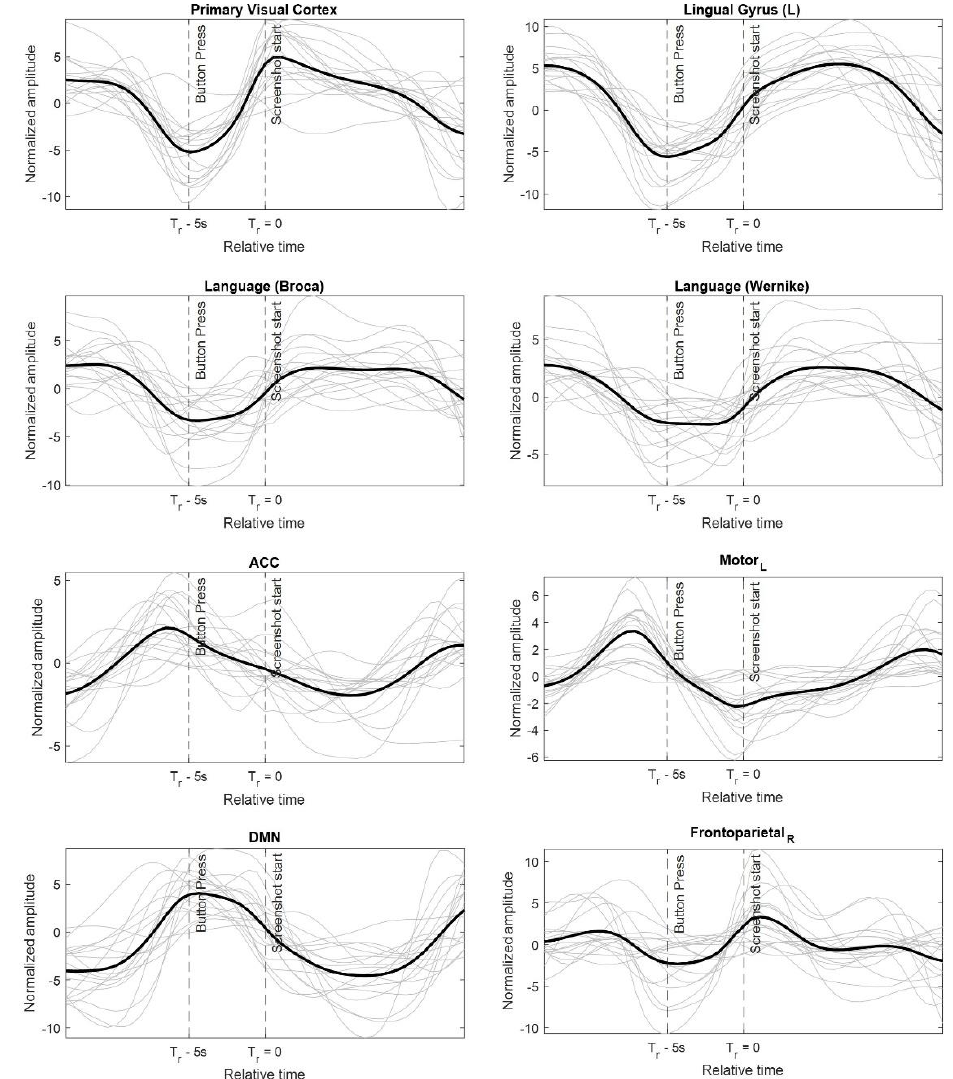
Figure 4. The estimated pseudo-stimulus (temporal response) for different voxels inside the brain. The plots in light grey correspond to the temporal response from single subjects while the dark black plot is the average across all participants. The vertical dotted line indicates the time instance of button press and beginning of the stimulus.